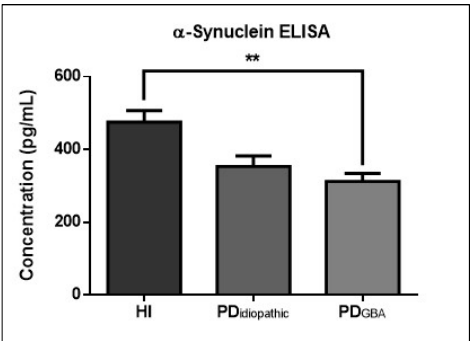
Figure 3. Correlation between α -Syn levels in CSF of PD patients with and without GBA mutations. The graph depicts the levels of α -Syn (pg/mL) in CSF from HI, PD idiopathic , and PD GBA cases. One-way ANOVA, followed by Tukey’s multiple comparisons test, was used for statistical analysis. Error bars represent SEM. (** p ≤ 0.01). 2.5. Gender-Specific Proteome Alterations in PD Patients with GBA Mutations To elucidate the effects of gender on the CSF proteome of PD patients, we segregated our PD cohort into male and female cases. The PCA plot visualizes the effects of GBA mutation on male and female PD patients. Although no obvious clusters can be observed for female cases, possibly due to the low sample number, male samples present clear clus- tering for samples with and without mutations (Figure 4A,B). We further analyzed the targets in a gender-specific manner to determine the proteins that were accounting for the variation among male and female clusters (Figure 4C,D). Modifications specific to males showed two-fold or more change in 31 proteins while those specific to females depicted changes in 29 targets. However, the latter group had two cases of PD cases without GBA mutations so they need to be interpreted with caution.